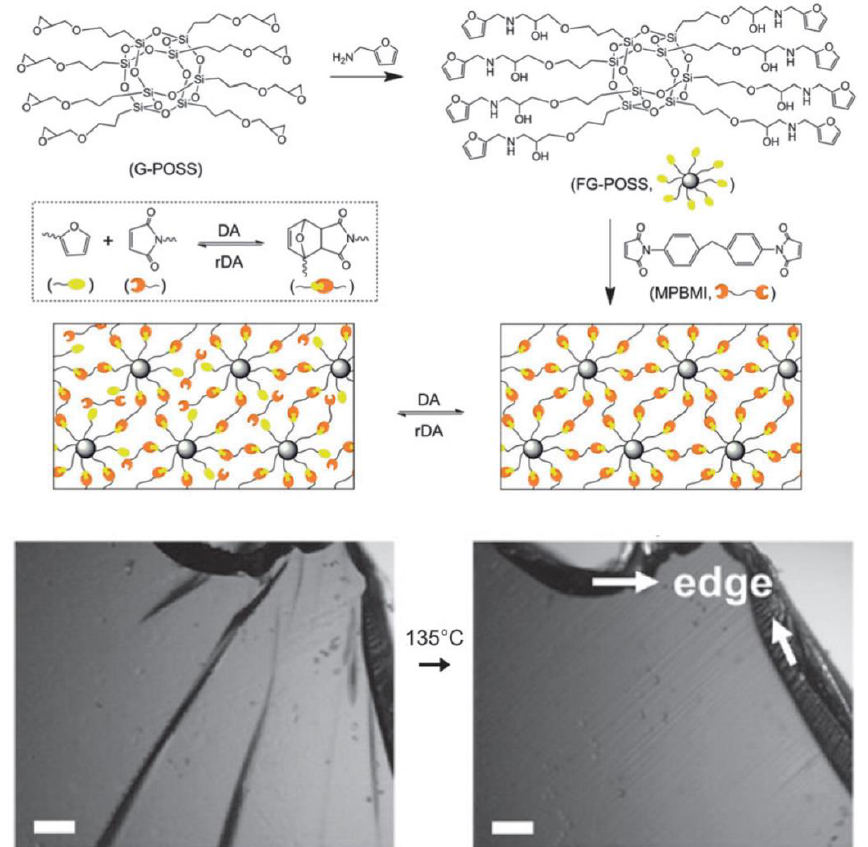
Figure 21. Cracked and self-healed sample after thermal treatment (30 min at 135 °C) with a DA and retro-DA reaction mechanism scheme (scale bar 1 mm). Reproduced from Chem. Commun . 2013, 49 , 6755 – 6757 with permission from the Royal Society of Chemistry [81].